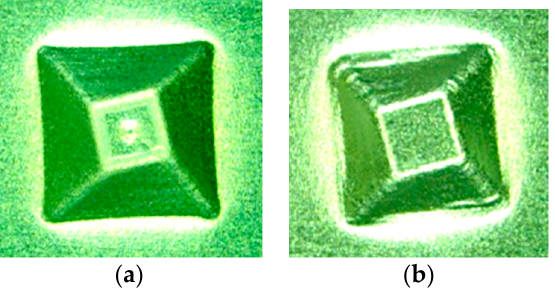
Figure 8. Top views of twisted pyramids formed: ( a ) with ultrasonic vibration; ( b ) without ultrasonic vibration.